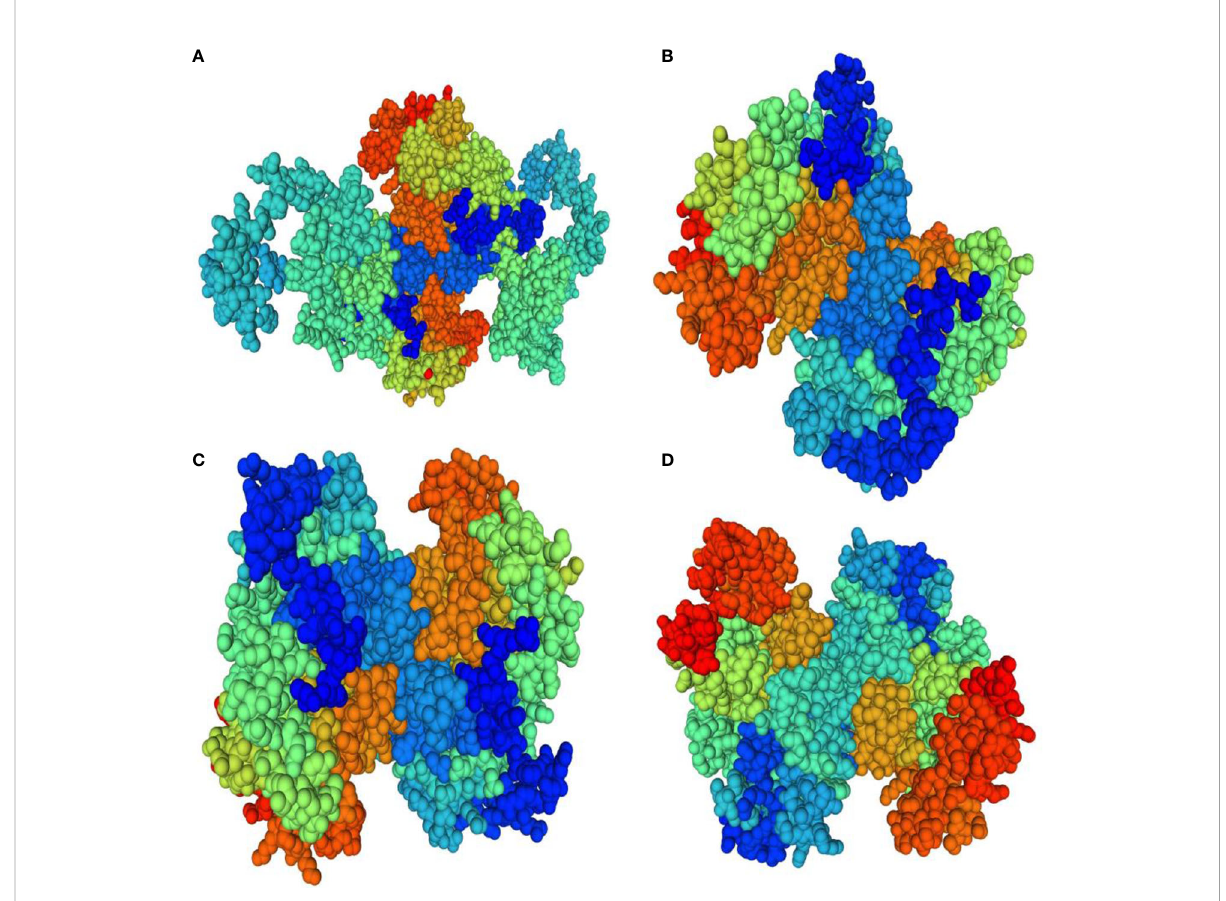
FIGURE 8 Predicted three dimensional structures of selenate transporters. (A) RLM65282.1 (B) RLN42222.1 (C) RLN18407.1 (D)